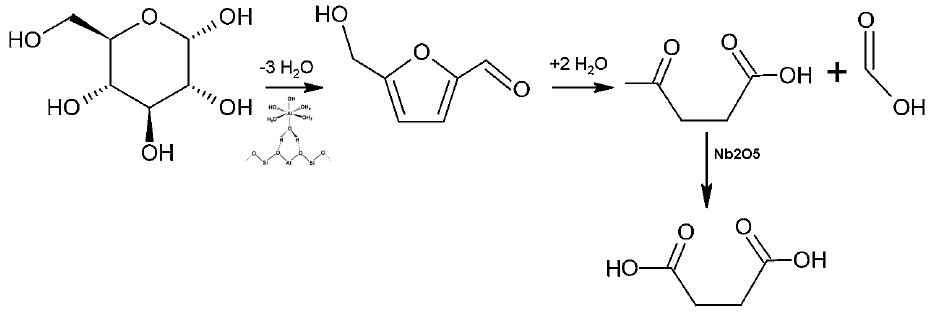
Scheme 1. The synthesis of succinic acid (SA) from glucose in two steps.